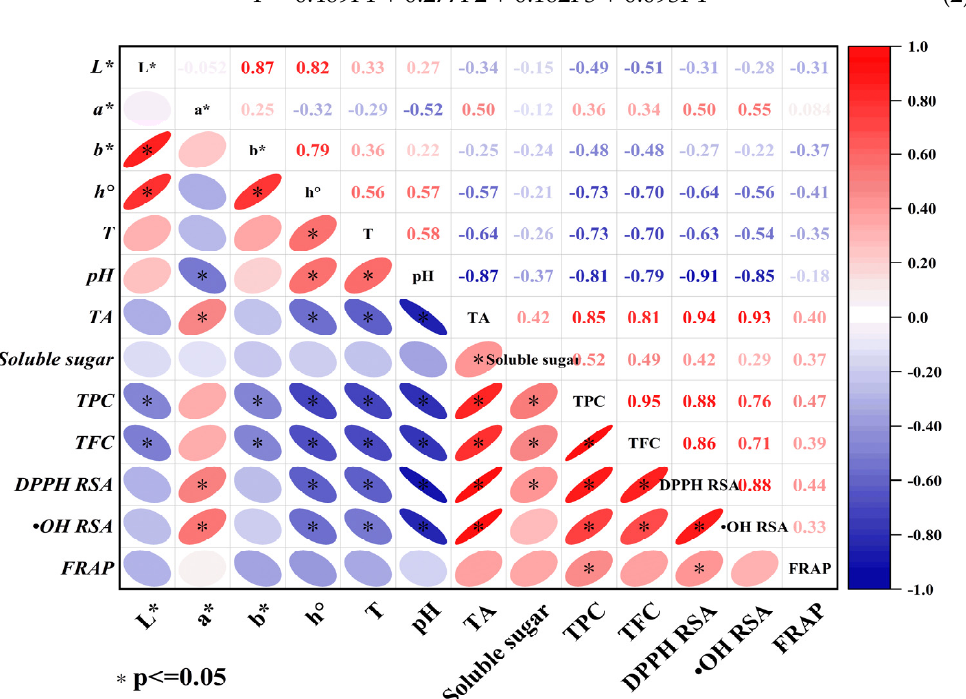
Table 5. Factor matrix including loadings, eigenvalues, percent of variance and cumulative variance for the first four principal factors.